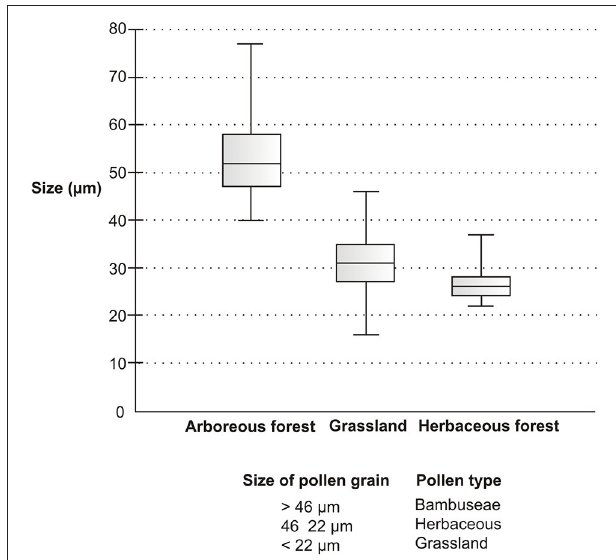
FIGURE 12 | Chart box plot of the diameters of the pollen grains. The bold horizontal line within the box represents the median. The box shows 50% of the interquartile range, and whiskers the total variation.